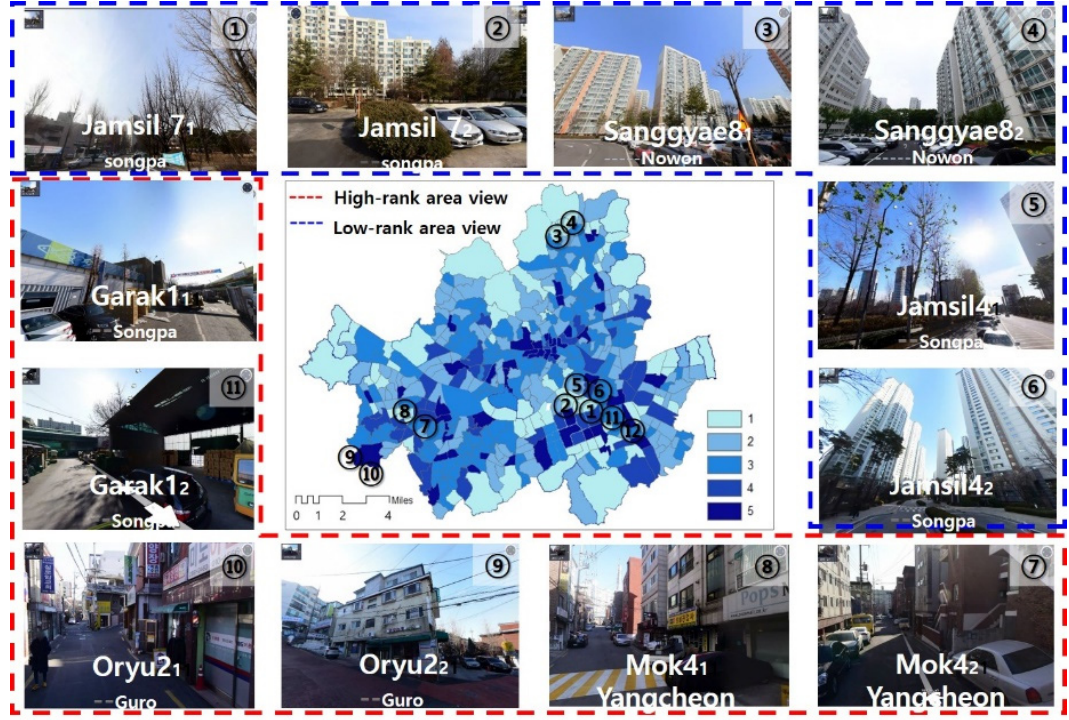
Figure A5 . Street views of top three-ranked and bottom three-ranked communities for climate exposure.